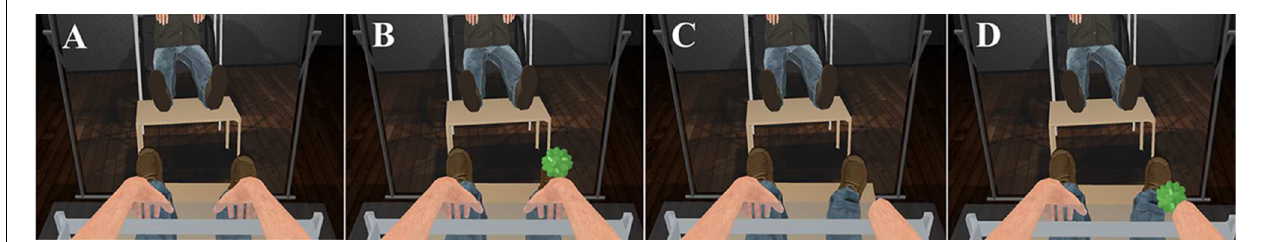
FIGURE 1 | The participant’s view from the HMD. (A) For both groups, a gender-matched virtual body was seen from 1PP with the same posture with the real body, as if they were spatially coincident. Participants were asked to look around and describe what they see (1 min). (B) For both groups, a virtual ball touched the right virtual hand various times while the real hand was physically touched at the same timings (2 min). (C) For the amputation group, part of the right virtual arm disappeared, as if amputated (3 min). (D) Following, the virtual ball touched the area previously occupied by the right virtual hand and part of the forearm (i.e., the table surface) without triggering any physical touch to the participant’s right hand (10